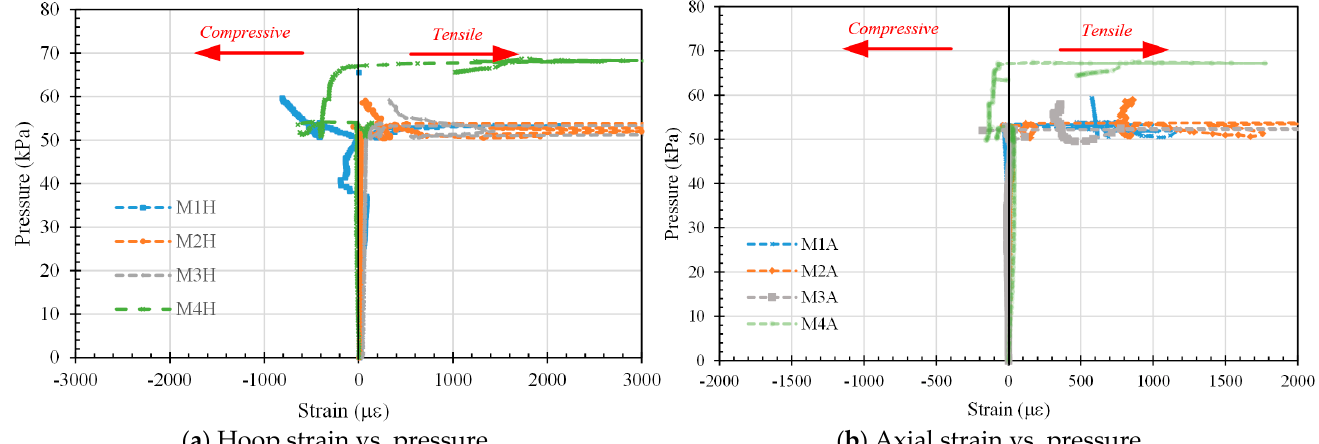
Figure 11. Pressure–strain curve in different modes of specimen 1 (T1).